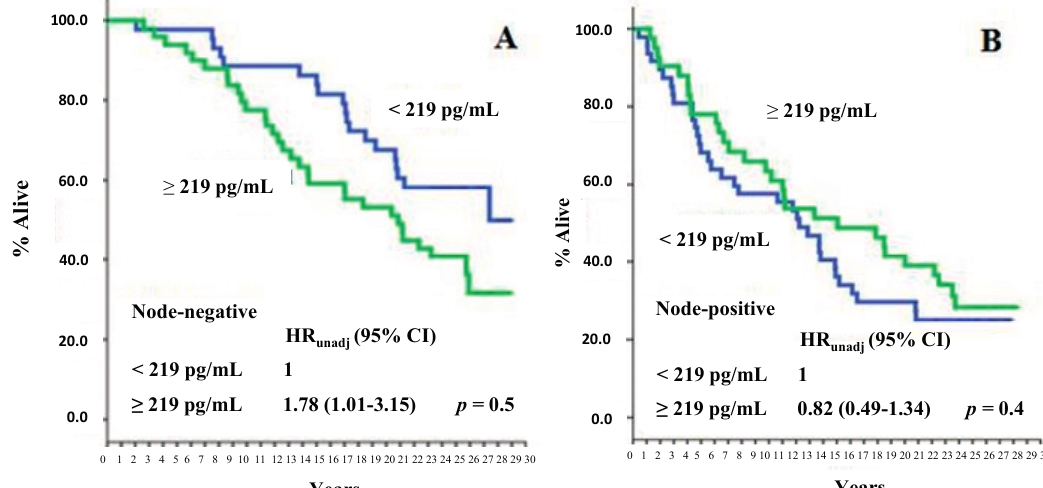
Figure 1. All-cause ( A ) and BCa-specific mortality ( B ) of study patients as a function of serum PN values. The median value, corresponding to 219 pg/mL, was used as an arbitrary cutoff. HR : hazard ratio; 95% CI : 95% confidence interval.